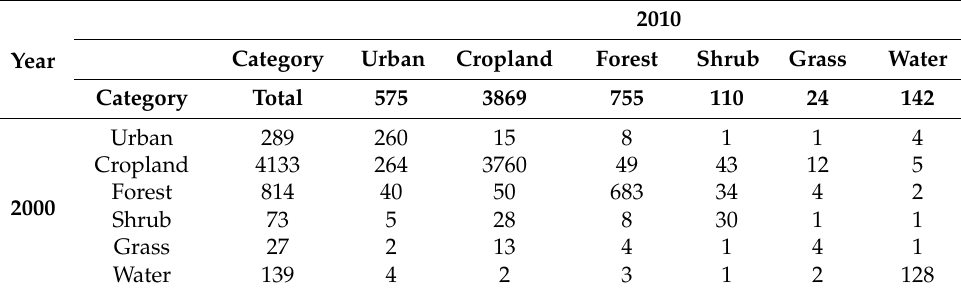
Table 4. LULC change matrix of Chongqing capital from 2000 to 2010 (unit: km 2 ).